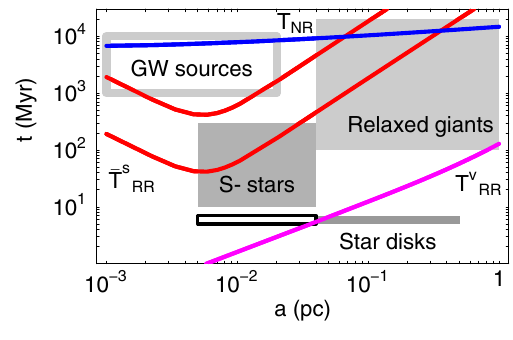
Fig. 46 The different timescales dominating stellar dynamics in the Galactic Centre. Image reproduced with permission from Hopman and Alexander (2006b), copyright by